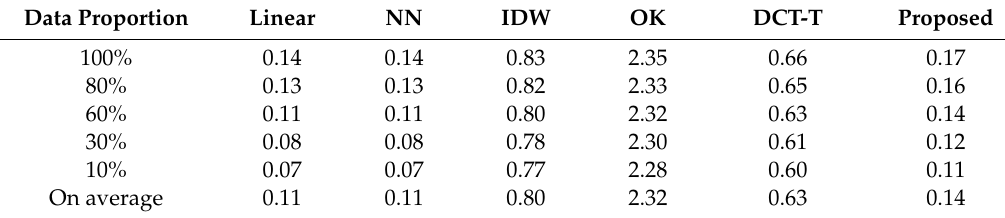
Table 8. Random-access memory costs of the proposed method and the other interpolation methods on the private dataset (unit: G).